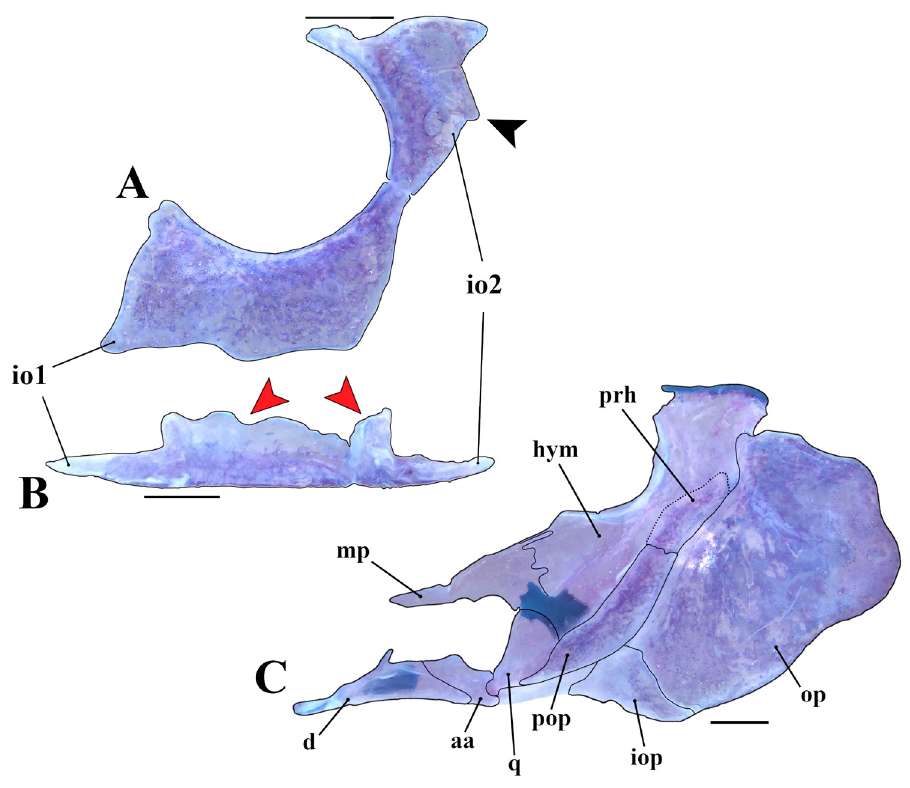
indicates the roughly triangular process on middle portion of posterior margin of infraorbital 2, and red arrows indicate inner laminar expansion of both infraorbitals. Scale bar = 1